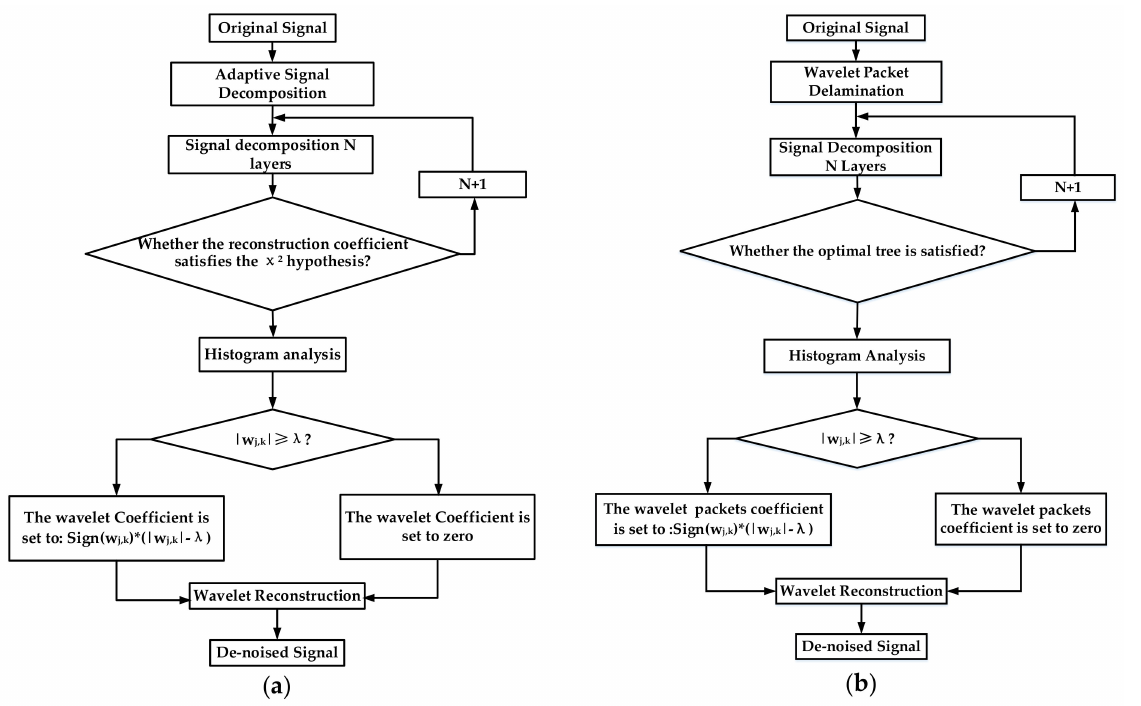
Figure 4. ( a ) Wavelet threshold denoising flow chart; ( b ) wavelet packet threshold denoising flow